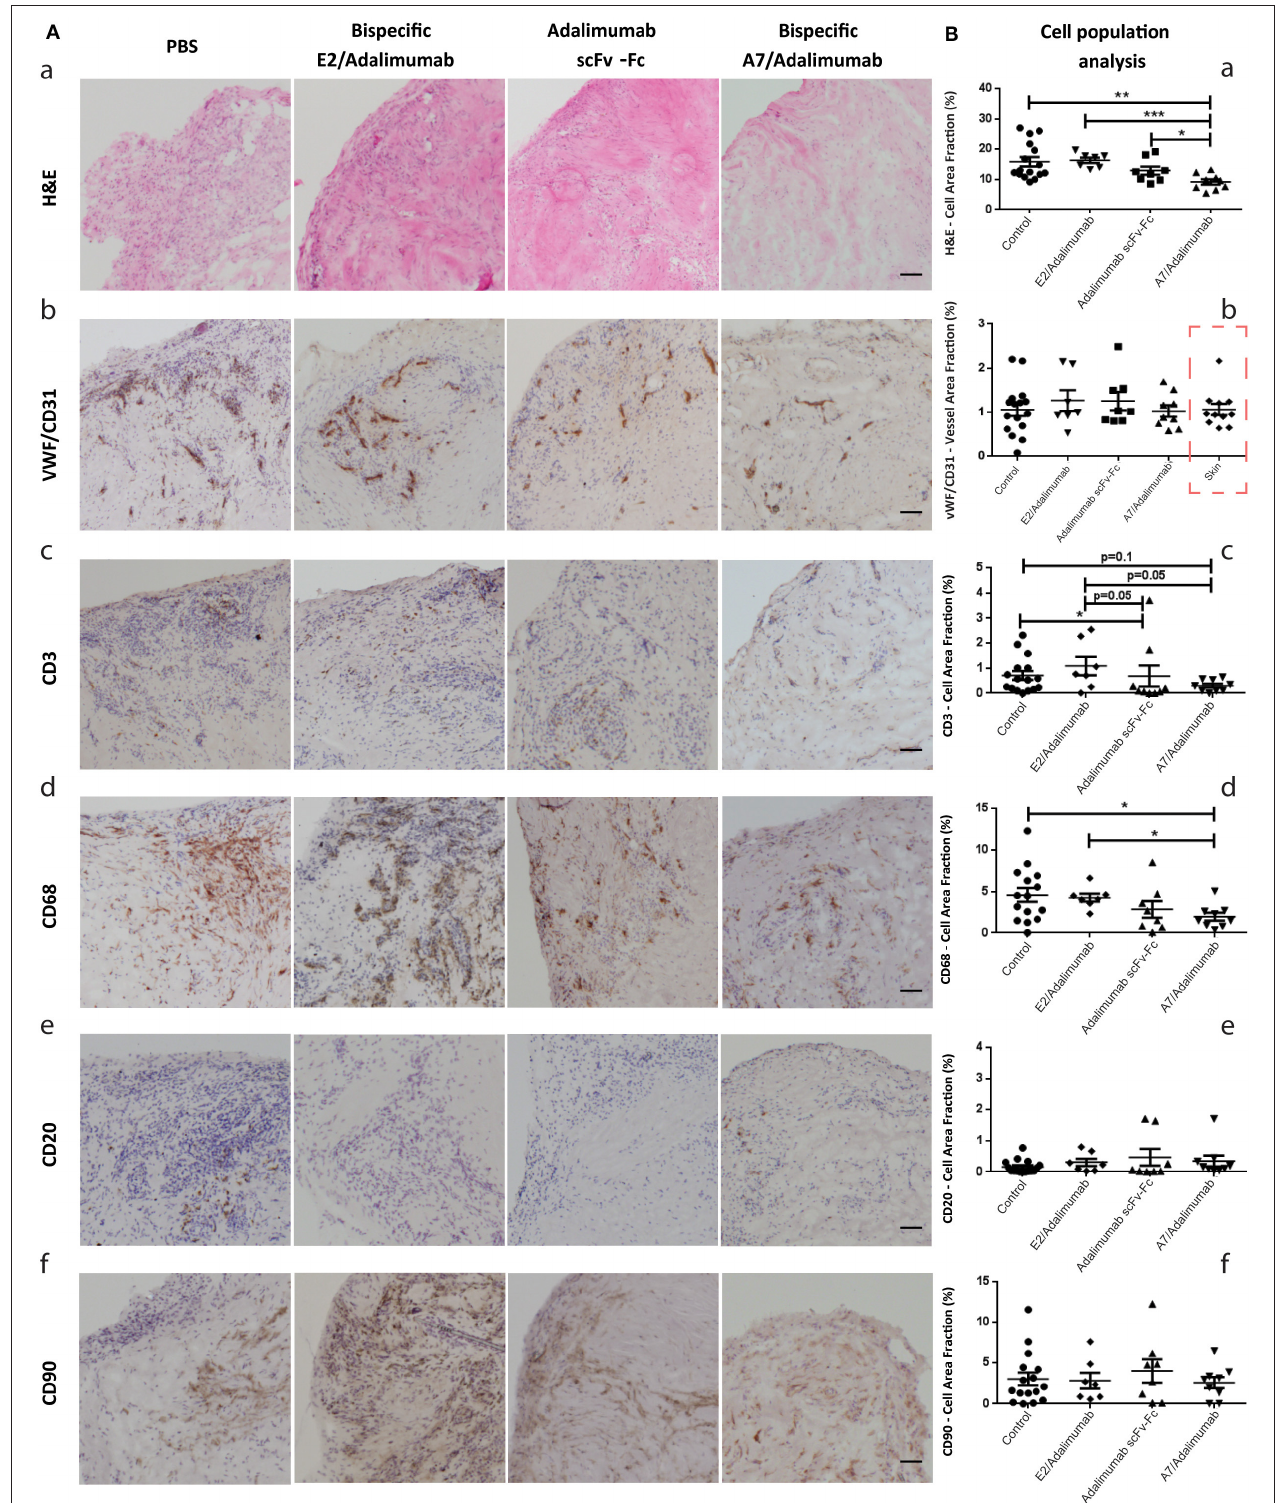
FIGURE 4 | Histomorphological features of human synovium xenografts. (A) Immunohistochemical analysis of synovial tissues from xenograft mice receiving PBS or A7 scFv-Fc (control group), adalimumab scFv-Fc, A7/adalimumab, or E2/adalimumab. H&E staining reveals the total cell population within the tissues, displaying